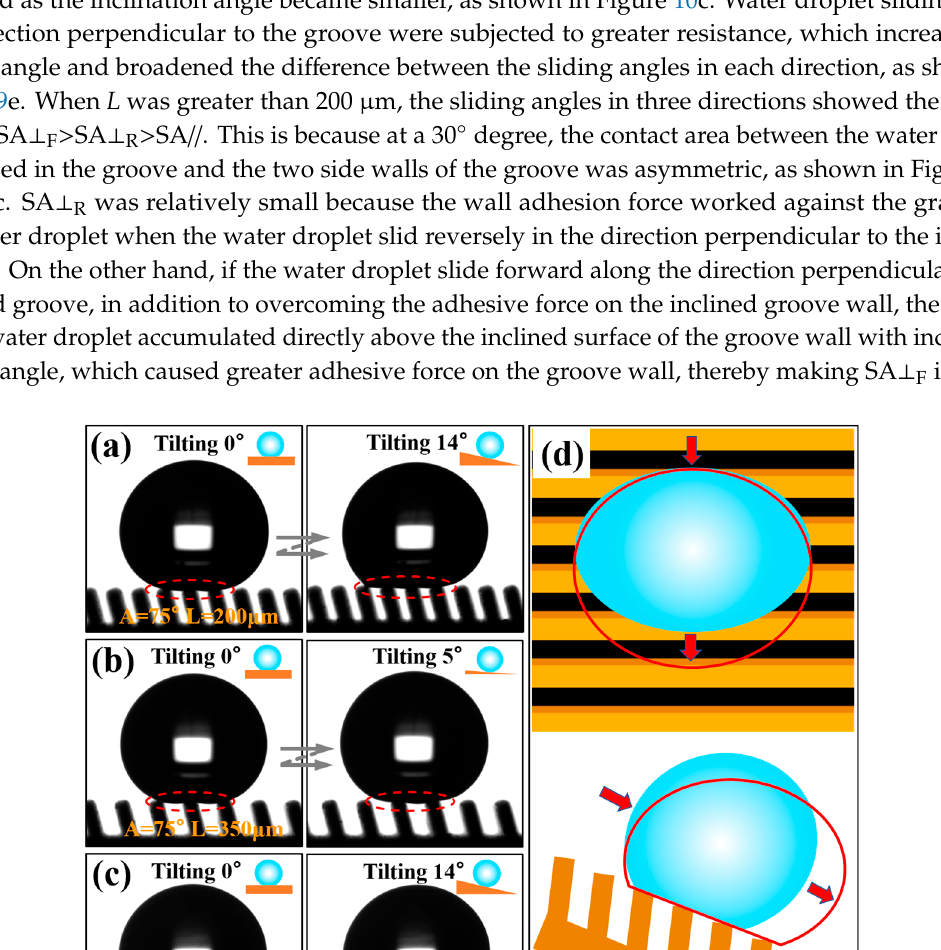
Figure 12. The condensation process of water droplets on different surfaces: ( a ) Smooth titanium alloy surface; ( b – d ) Superhydrophobic titanium alloy surface ∥ , ⊥ F and ⊥ R direction; ( e ) Condensed water droplets state on the superhydrophobic titanium alloy surface, ( f ) Condensed water droplet contact angle. As shown in Figure 12a, condensed water droplets rapidly condensed into a smaller water film on the smooth surface of titanium alloy, a large water film formed as the condensation continued. However, smaller oval droplets condense on the surface of the superhydrophobic titanium alloy. This is the submillimeter groove structure that regulates the growth of the water droplets [32], inhibits the